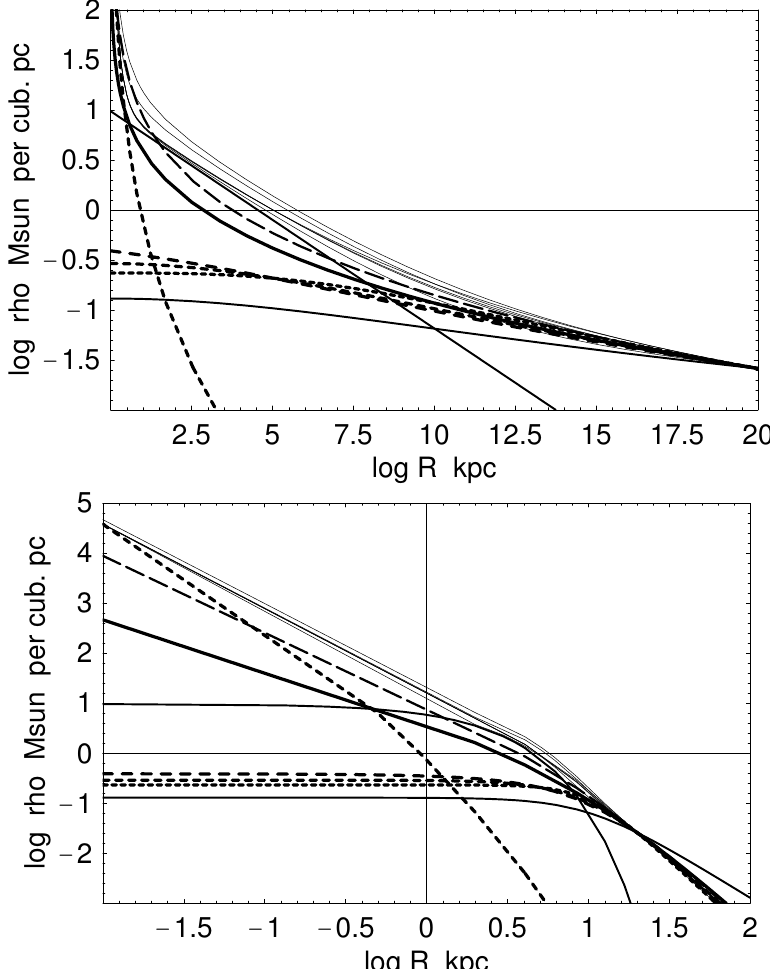
Figure 2. ( Top ) Schematic density profiles of NFW (Navarro, Frenk, White) (thick solid), Moore (upper long dash), Burkert (long dash), Brownstein (dot), β (dash), and isothermal (thin solid) models with h = 10 kpc normalized at 20 kpc, compared with the disk (straight line) and bulge (inner thick dash). Uppermost thin lines are the sum of bulge, disk and halo. ( Bottom ) Same, but in log–log plot. The NFW cusp and cored halos do not much contribute to the mass density in the GC, whereas the Moore cusp somehow resembles the bulge